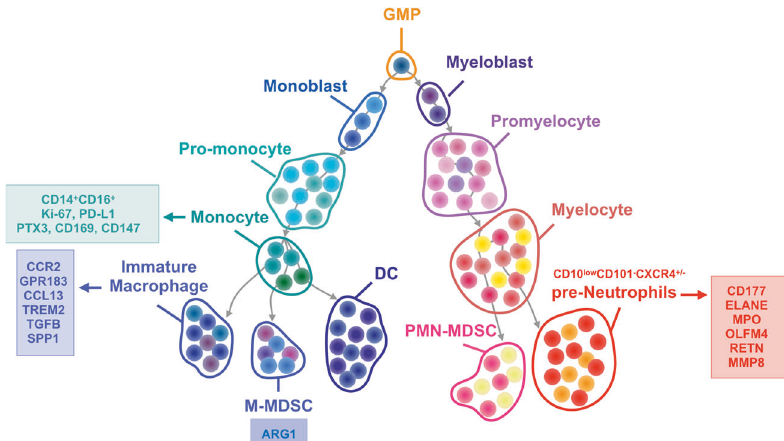
Fig. 1 The differentiation trajectory of myeloid cells in COVID-19 microenvironment derived from the results of single-cell sequencing analysis. GMP differentiates into myeloblasts and monoblasts, and monoblasts differentiate into pro-monocytes and monocytes in the bone marrow. With COVID-19 infection, monocytes differentiate into macrophages and DCs in infected lung tissues and M-MDSCs in circulation. The expression of biomarkers such as Ki-67, PD-L1, PTX3, CD169, and CD147 was increased in monocytes, whereas monocytes mainly presented the CD14 + CD16 + phenotype in severe COVID-19 patients. PMN-MDSC and pre-Neutrophil differentiation progresses through myeloblasts and myelocytes. In severe COVID-19 patients, pre-neutrophils such as CD10 low CD101 − CXCR4 + / − subsets, highly expressed CD177, ELANE, MPO, OLFM4, RETN, and